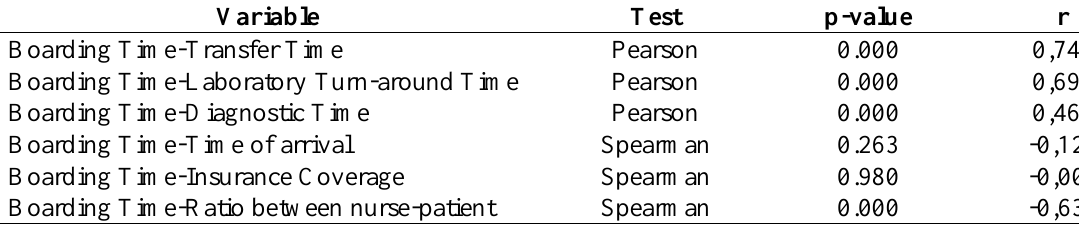
Table 2. Result of the bivariate analysis